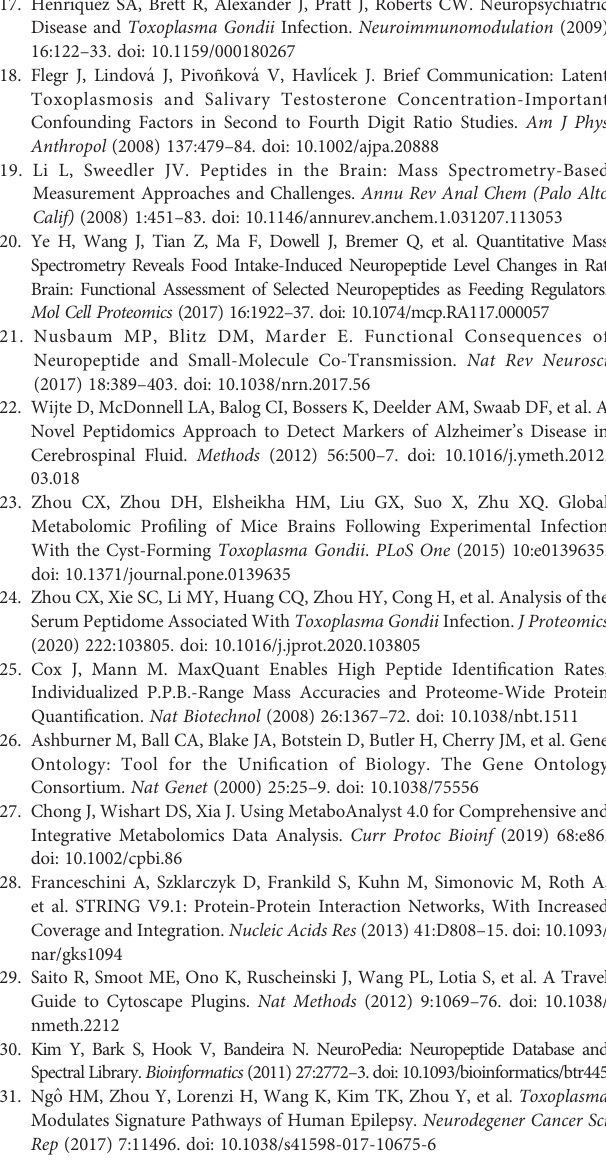
Supplementary Figure 1 | Statistics of peptides identi fi ed from brain and serum. Supplementary Figure 2 | Peptide pro fi les analysis between acutely infected group and chronically infected group. (A) Heat map of endogenous peptides. Columns were hierarchically clustered based on a complete linkage using Pearson correlation coef fi cients as the distance measure. (B) The volcano plot shows the individual statistically signi fi cant peptide between acutely infected group and chronically infected group. In this plot, the x-axis is log2 fold-change, which shows the direction of the change (negative scale is decrease and positive scale is increase) in the levels of peptide intensity, while the y-axis is the -log10 p -value, which shows the signi fi cance of the change. Supplementary Figure 3 | Functional analysis of the precursor protein of DEPs in the comparison between the CI and the control group. (A) GO analysis. (B) PPI analysis. Supplementary Table 1 | A list of peptides detected in mouse brain and